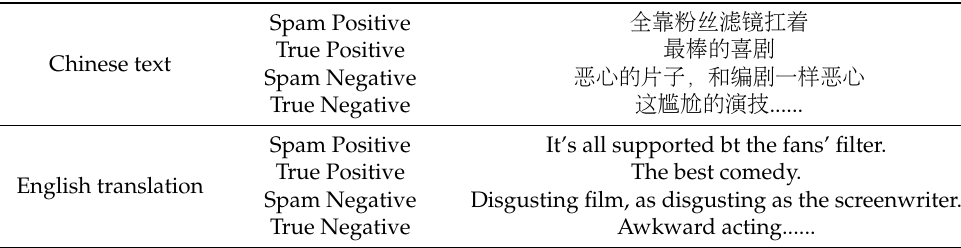
Table 12. Samples from Douban Movie Review Dataset.